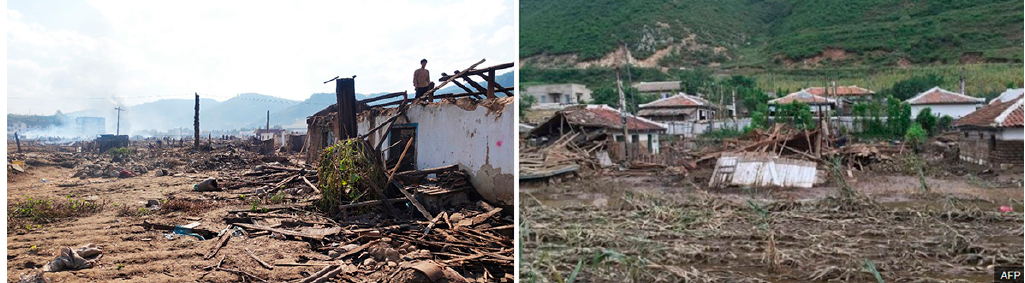
Figure 2. Flood damage in Hoeryeong City in August of 2016 (http://kp.one.un.org/content/unct/dprk/ en/home/emergency-response/floods-2016.html, http://www.bbc.com/news/world-asia-37335857).